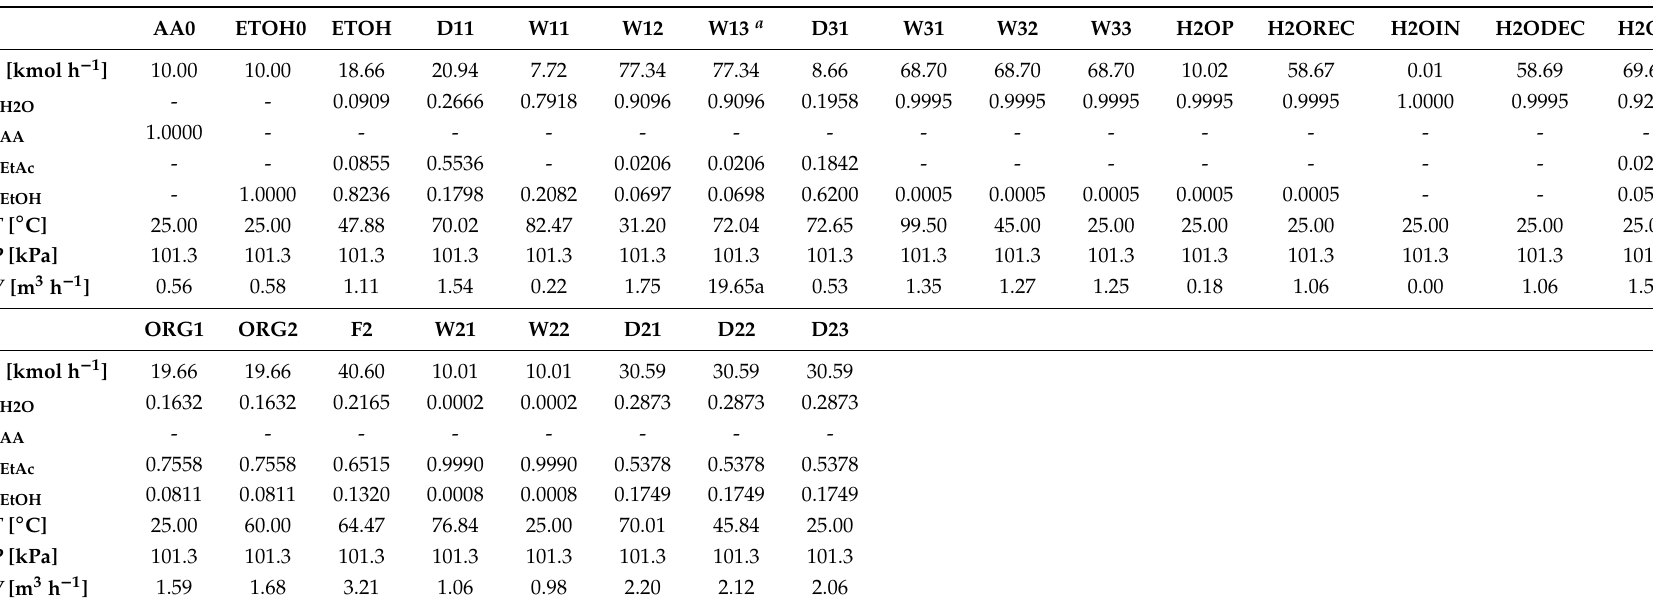
Table 3. Material balance of designed RD column with a separation unit (Figure